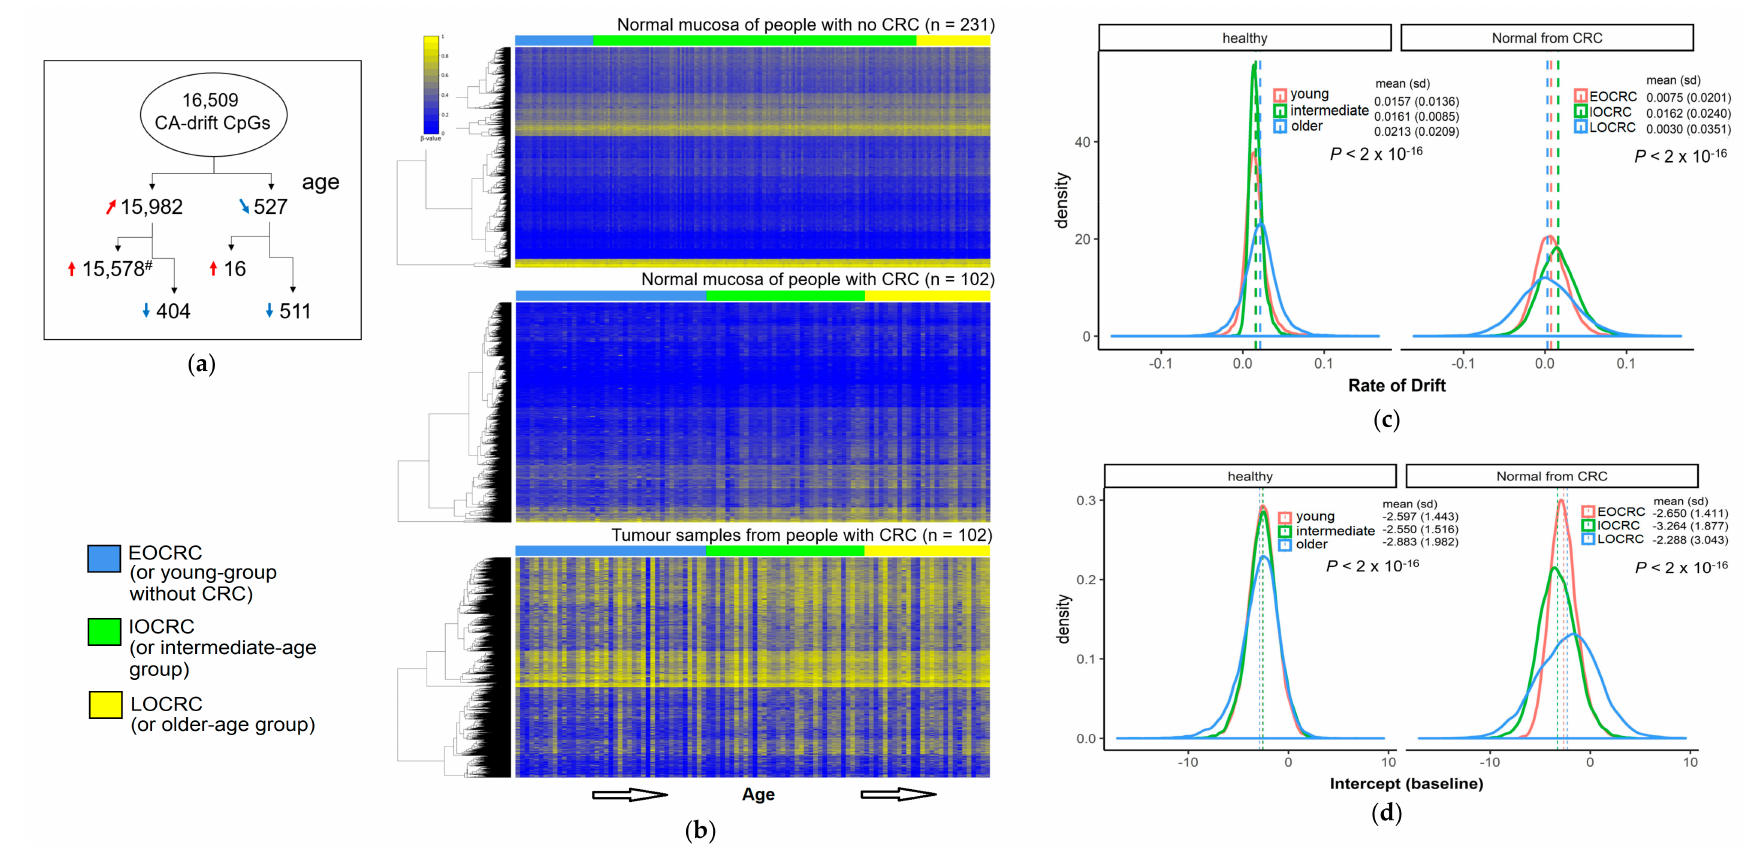
Figure 3. ( a ) Schema describing number breakdowns for CA-drift CpGs positively (red arrow) and negatively (blue arrow) correlated with increasing age and hyper (red) and hypomethylated (blue) in CRCs. # CpGs included in subsequent analyses ( b ) DNA methylation heatmap illustrating methylation patterns across 15,578 CA-drift CpGs ( y -axis) for 231 normal mucosa samples ( x -axis) from the healthy group. Individual samples are shown along the horizontal axis and order by increasing age for 102 normal mucosa samples and 102 tumour samples from people with CRC. ( c ) Density plots showing the distribution of the drift rate for young/early (or EOCRC), intermediate (or IOCRC), and late age (or LOCRC) group samples from people without CRC and with CRC. ( d ) Density plots showing the baseline of the drift rate (using intercept as